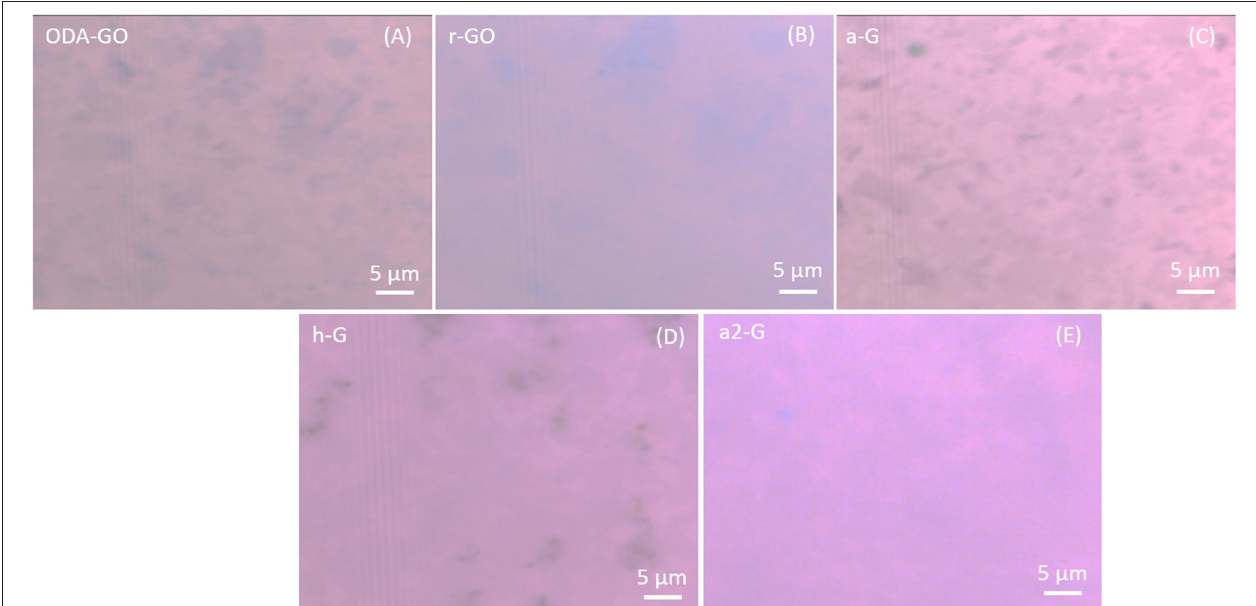
FIGURE 3 | Optical micrographs of the samples after each different process. (A) As deposited ODA-GO, (B) r-GO, (C) a-G, (D) h-G, and (E) a2-G.